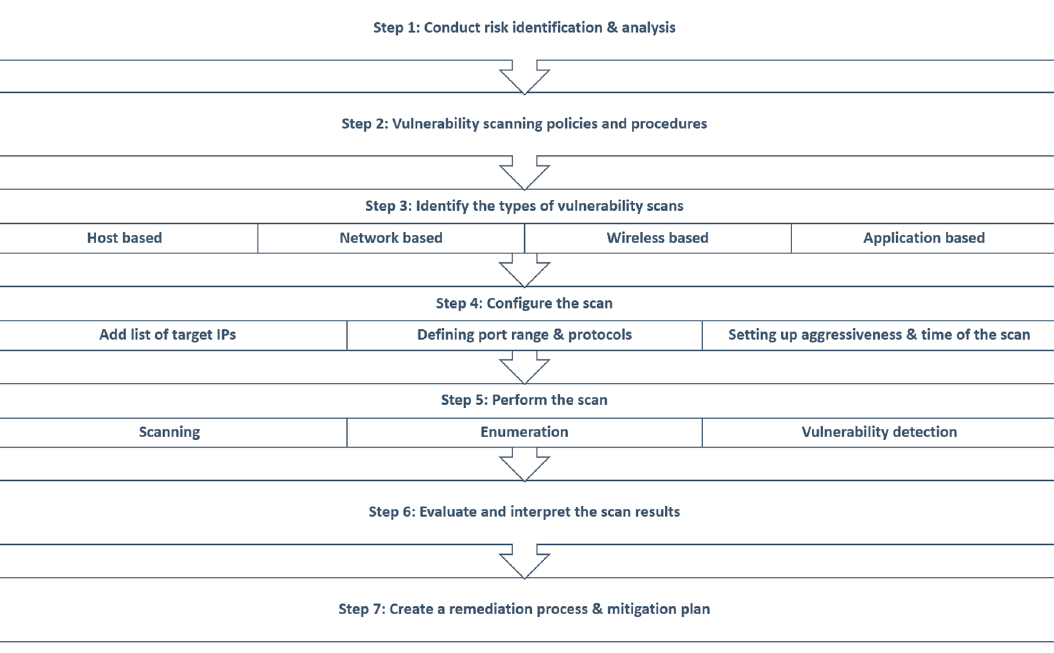
Figure 7. Generic framework of vulnerability assessment process.